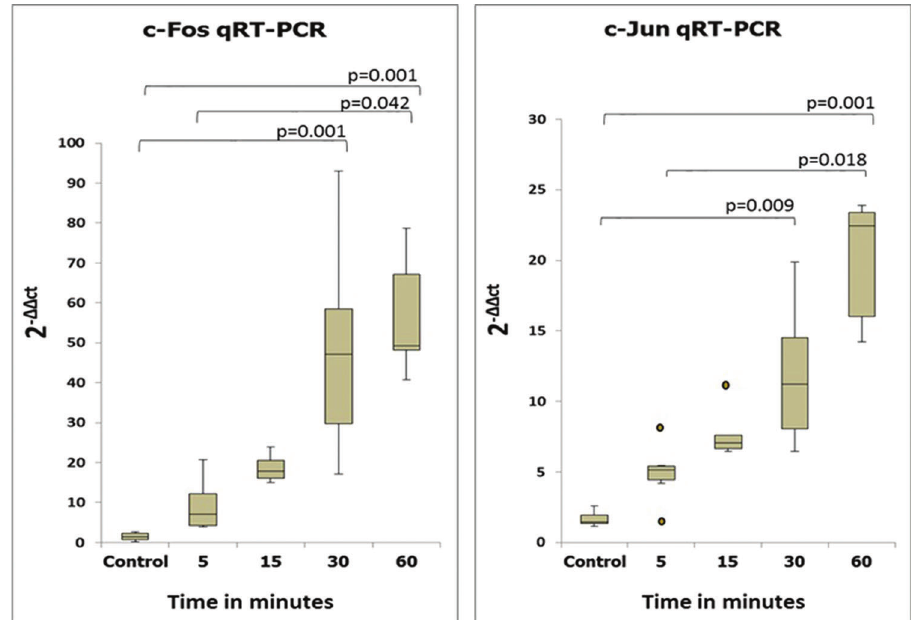
Figure 3 - The sequential expression patterns of c- fos and c- jun mRNA (quantitative method). Note that these results are similar to those obtained using the semiquantitative method.